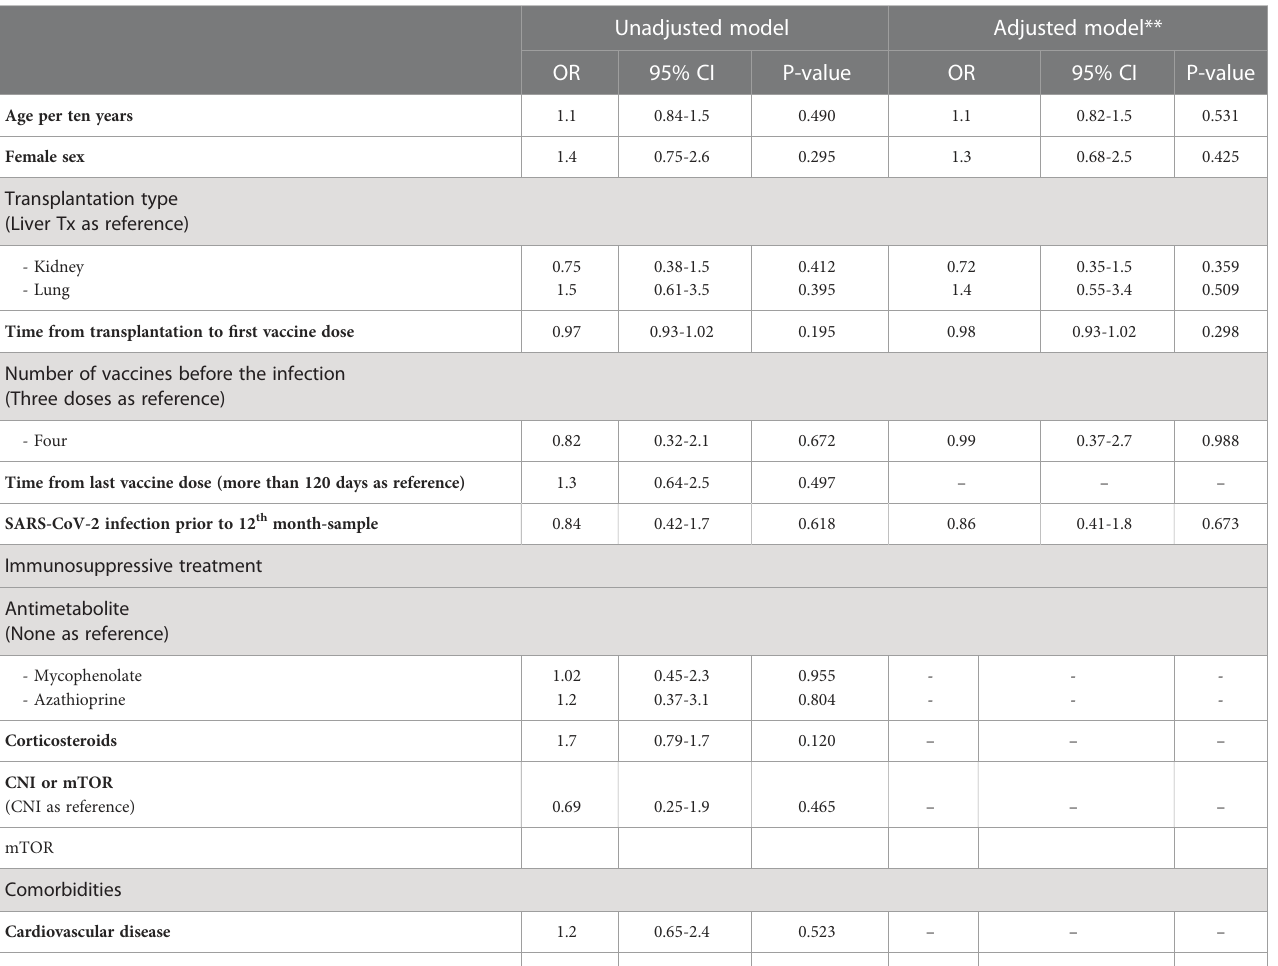
TABLE 4 Risk factors for T-cell non